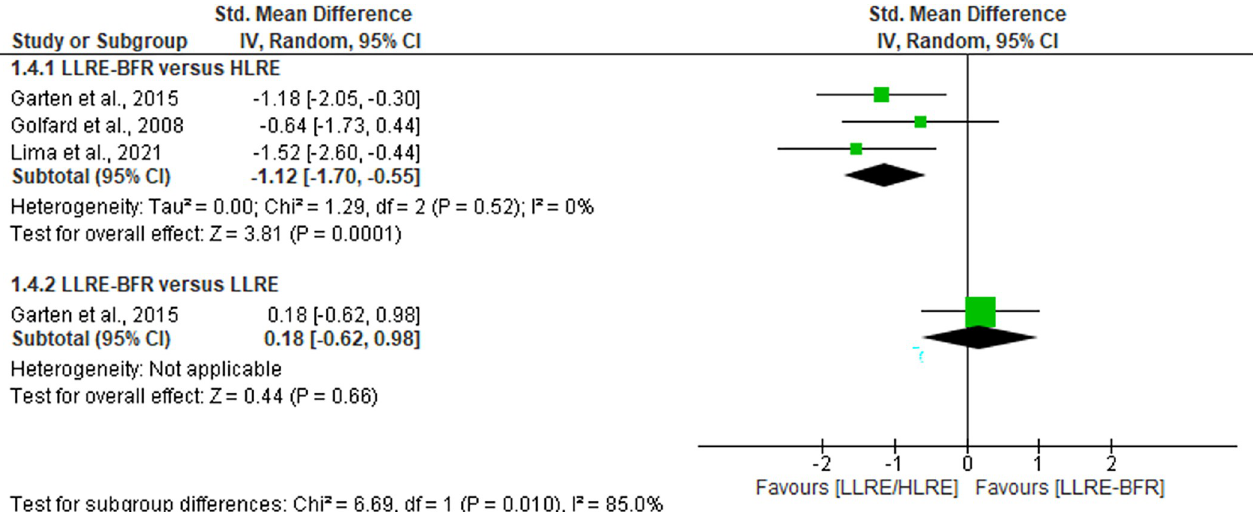
Fig 7. Forest plot about effects of LLRE-BFR versus HLRE on glutathione redox ratio post-exercise. LLRE-BFR: Low load resistance exercise with blood flow restriction; HLRE: High-load resistance exercise, LLRE: Low load resistance exercise; SMD: Standardized mean difference; SD: Standard deviation; IV: Inverse variance; CI: Confidence